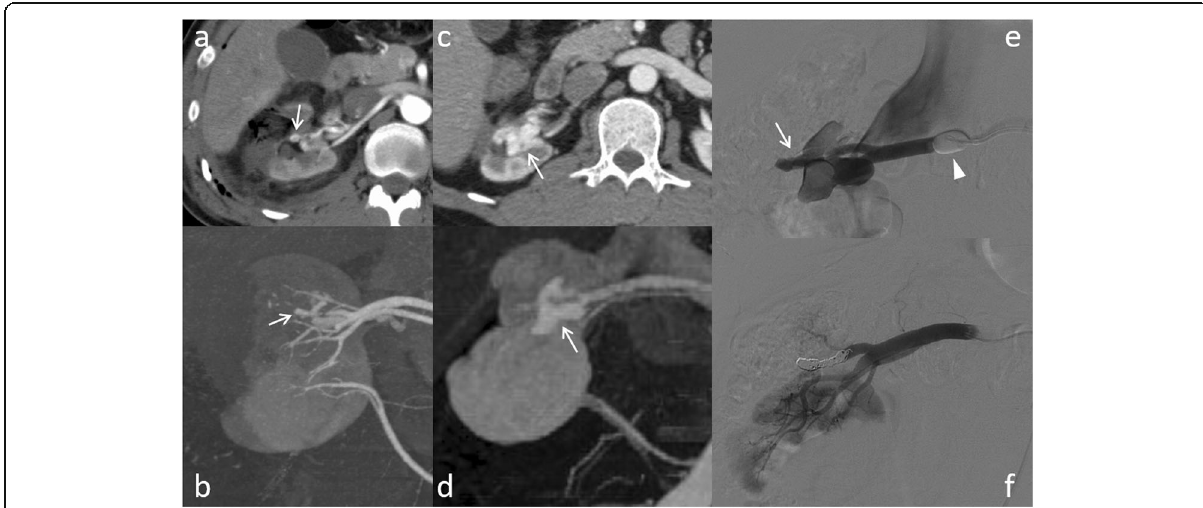
Fig. 5 A case of an increasing arteriovenous fistula (AVF), without symptoms, in a 40-year-old man. a , b Irregularly shaped enhancement (arrows) is suspected on early postoperative contrast-enhanced CT on postoperative day (POD) four. c , d It is increased in size and AVF is suspected (arrows) on follow-up CT after 1 year without symptoms. e The AVF (arrow) is embolized using microcoils under balloon occlusion (arrowhead) on POD 414